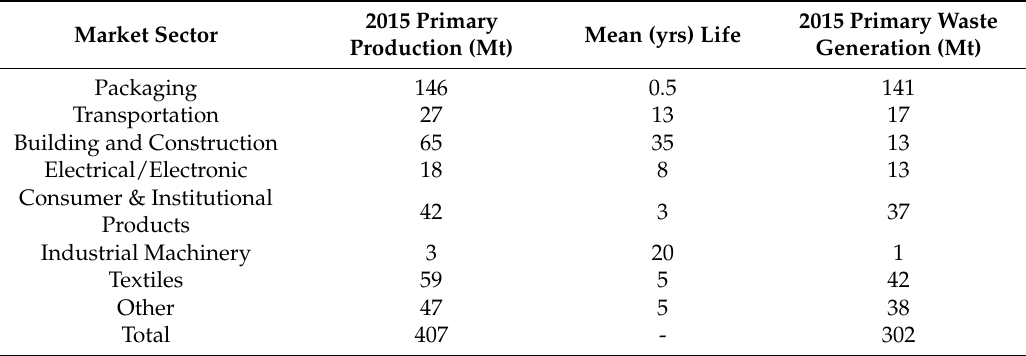
Figure 1. Life cycle of plastics [2]. Table 1. Global primary plastics production, lifetime distribution of the product and primary waste generation (in million metric tons) in 2015 according to industrial use sector [3].